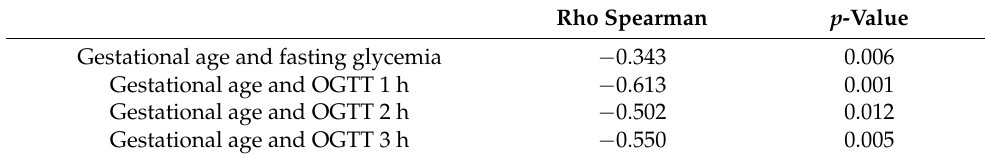
Table 3. Correlation between gestational age at delivery and diagnostic tests for GDM.